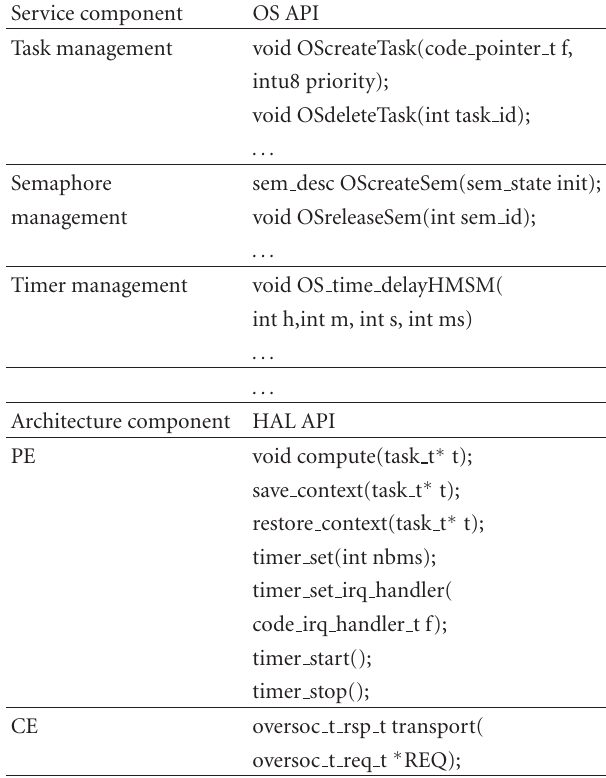
Table 1: Example of services provided by the OS and HAL API. Service